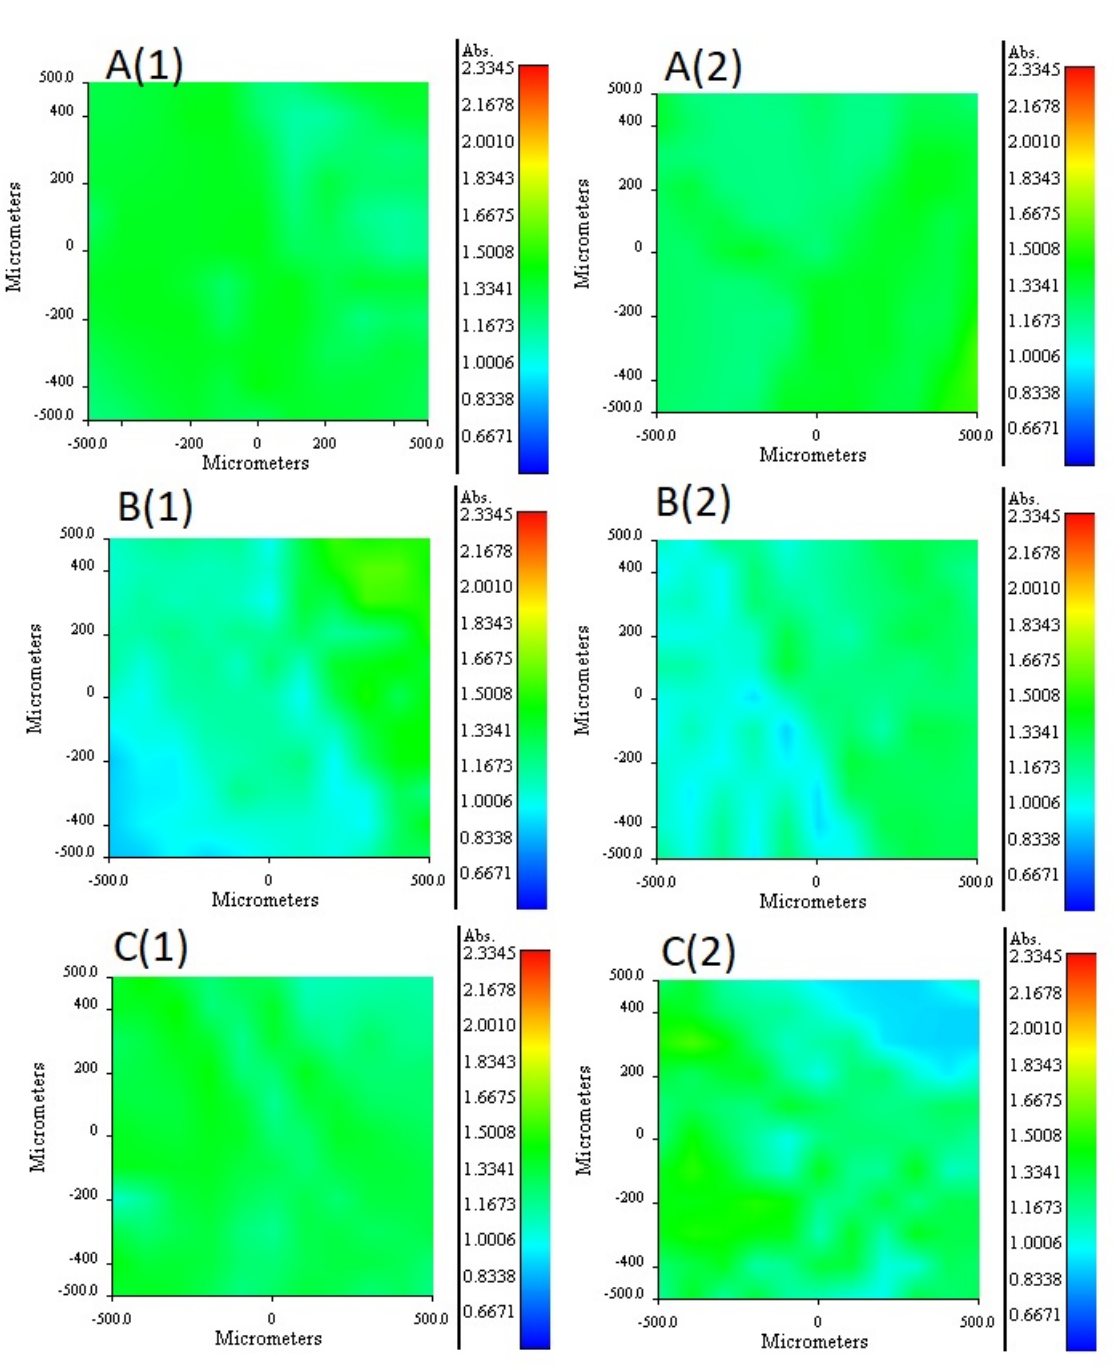
Figure 5. RIMM maps monitoring the distribution of 2NPOE in PIM 41 ( A ), Ionquest ® 801 in PIM 39 ( B ), and TBEP in PIM 40 ( C ). (1) stands for face 1 and (2) for face 2 of the PIMs (see text).